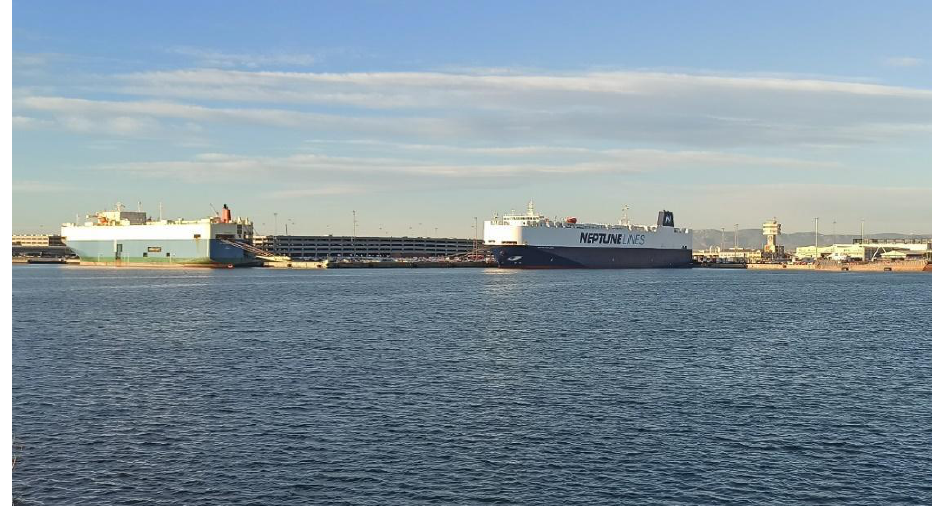
Figure 4. View of the South basin of Barcelona port. Source: The Authors.